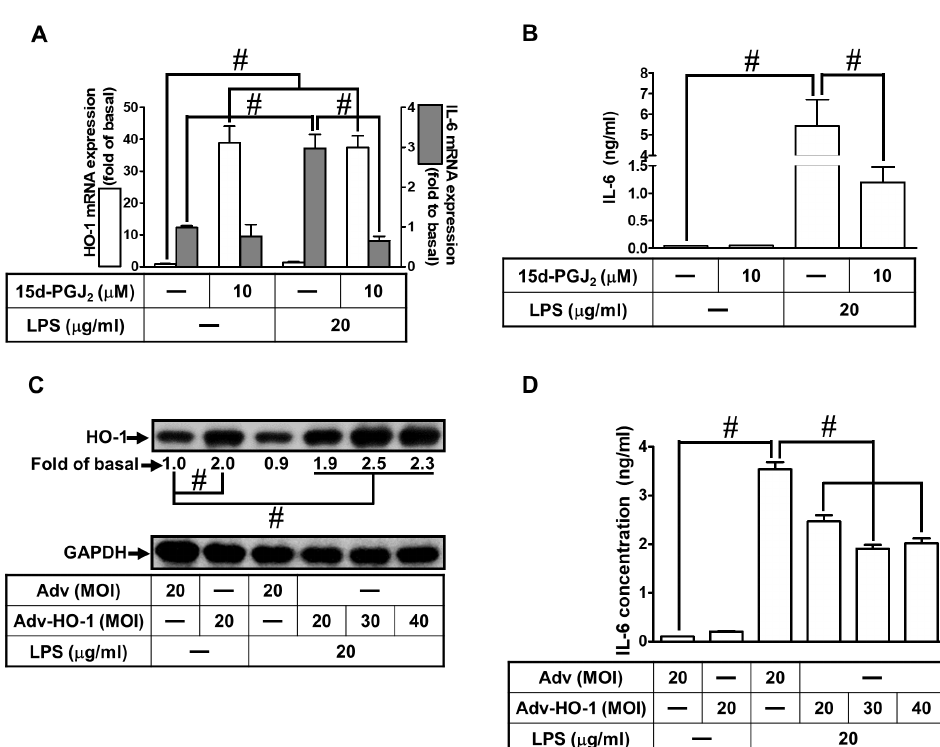
Figure 7. HO-1 upregulation by 15d-PGJ 2 attenuates LPS-stimulated IL-6 secretion in bEnd.3 cells. ( A , B ) The cells were pretreated with 10 μM 15d-PGJ 2 for 1 h and then challenged with 20 μg/mL LPS for 4 h. ( A ) The cell lysates were collected to analyze the mRNA expression of IL-6 and HO-1 by real-time PCR. ( B ) The media were collected to measure the secretion of IL-6 by an ELISA kit. ( C , D ) Cells were infected with the vector of adenovirus or adenovirus-HO-1 at the indicated MOI (20, 30, and 40) for 48 h and then challenged with or without 20 µ g/mL LPS for 6 h. ( C ) The cell lysates were examined for the protein expression of HO-1 by Western blot, with GAPDH as an internal control. ( D ) The media were collected to measure the secretion of IL-6 by an ELISA kit. Data are summarized and expressed as mean ± S.E.M. for four individual experiments. # p < 0.01, as compared with the basal level or the cells treated with 15d-PGJ 2 alone. Abbreviations: Adv: adenovirus; IL-6: interleukin-6; LPS: lipopolysaccharide; MOI: multiplicity of